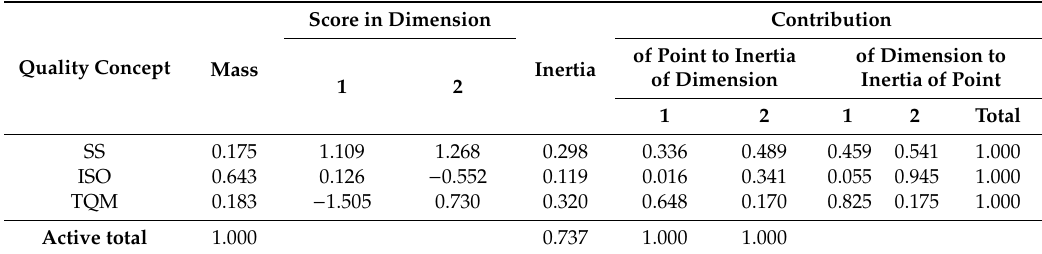
Table 5. Overview of row points.